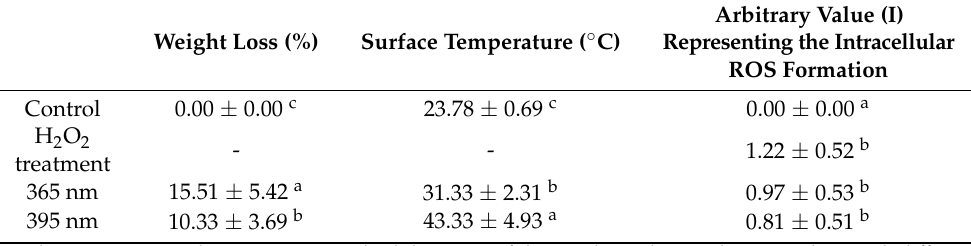
Results are represented as means ± standard deviation of three independent replicates. Values with different superscripts in each column differ significantly ( p <